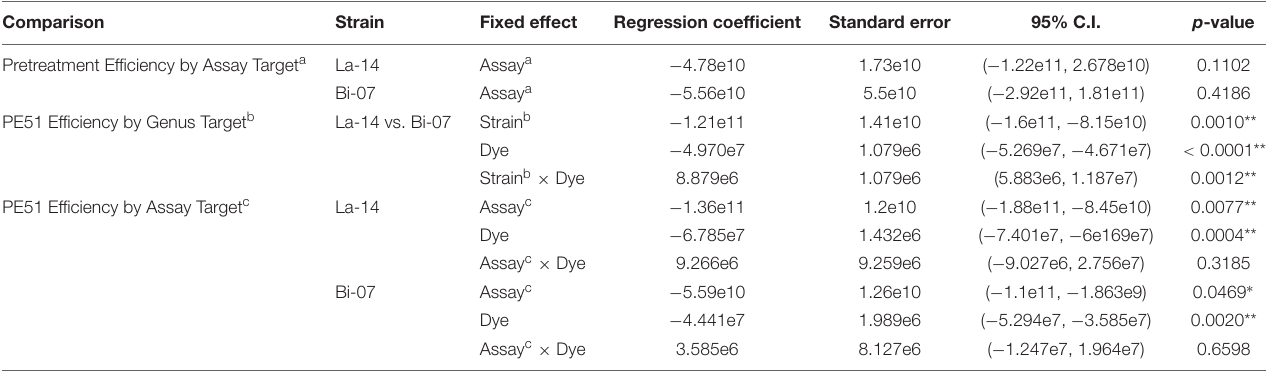
TABLE 2 | Results of linear mixed effects model examining the influences of assay target and genus target on the cell enumeration with Lot as a random effect factor.